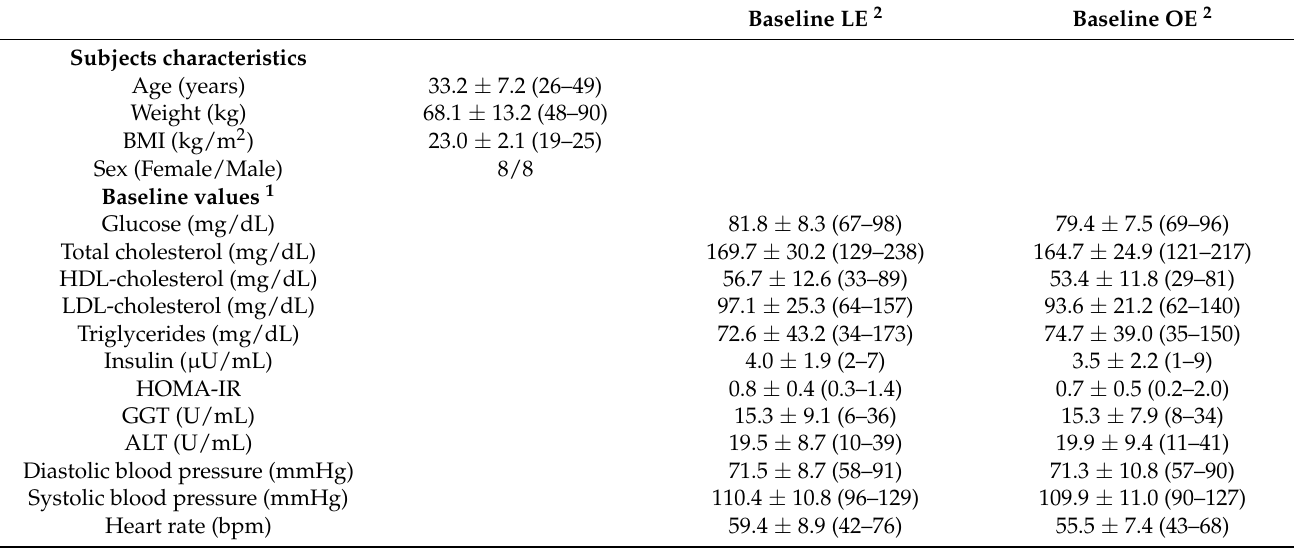
Table 1. Subjects characteristics and baseline values of the volunteers 1